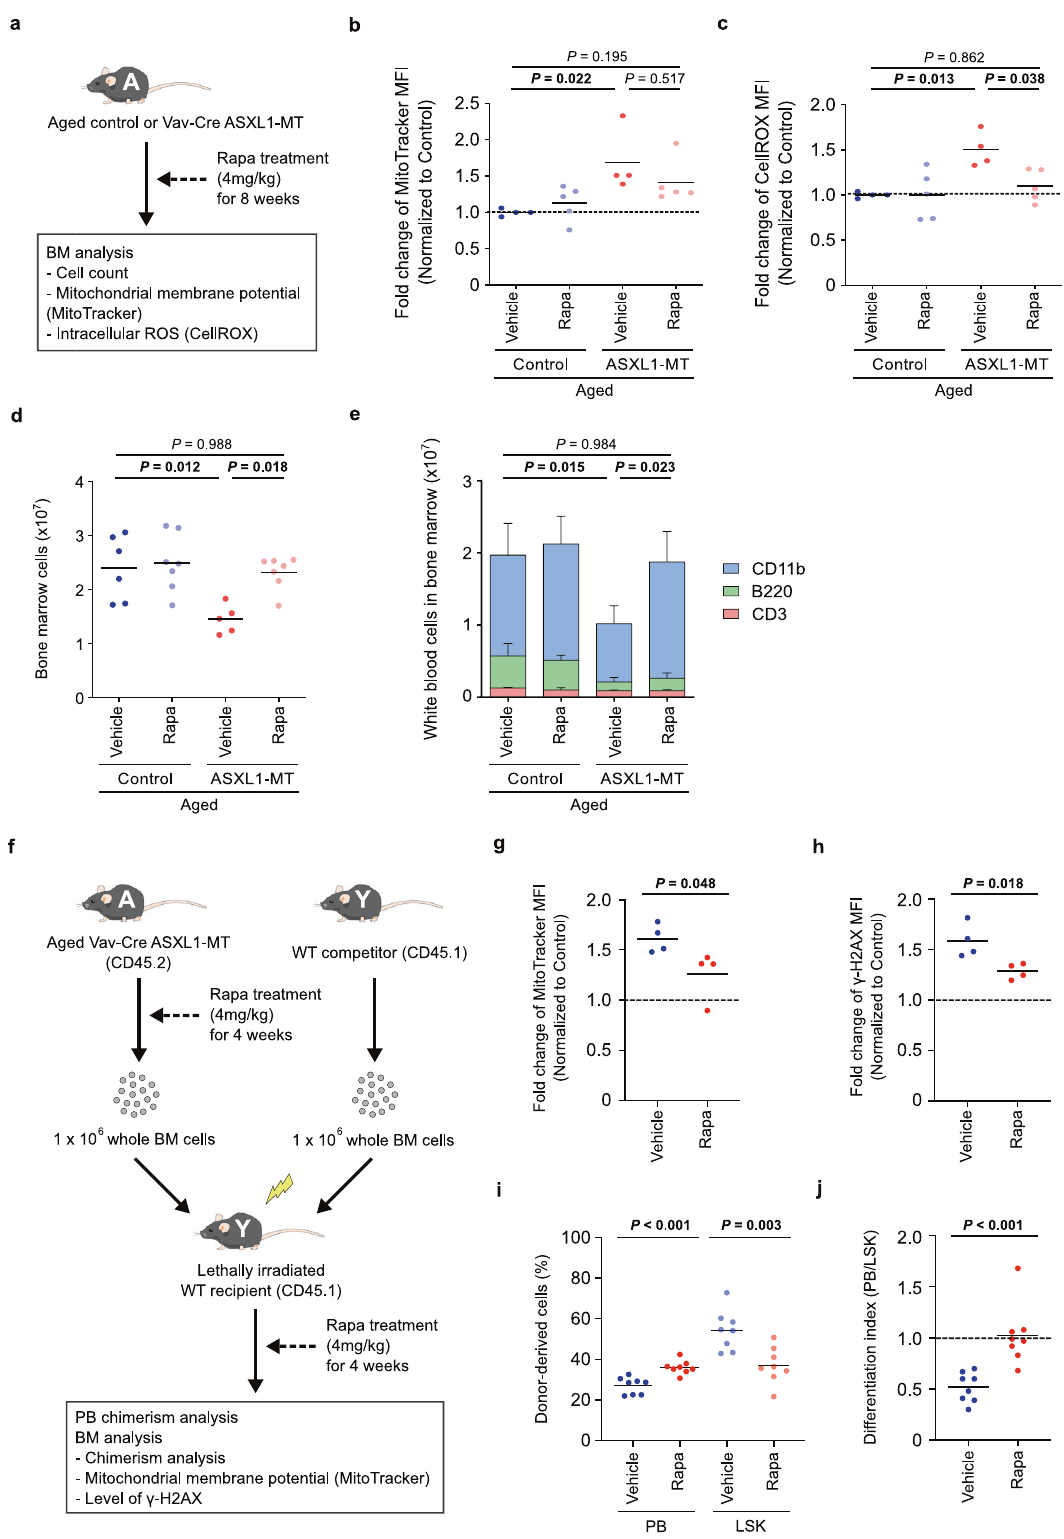
sequenced on the Illumina HiSeq2500 System with 2× 100 nucleotide paired-end reads according to the manufacturer ’ s protocol. Derived reads were processed using cutadapt (1.8.1) and fastx-toolkit (0.0.13) to remove Illumina adaptor sequence and to trim low-quality bases. Quality of reads was assessed using FastQC. Processed reads were aligned to GRCm38 reference transcripts using TopHat (2.1.1) — Cuf fl inks (2.1.1) pipeline to derive gene FPKM values 73 – 75 .